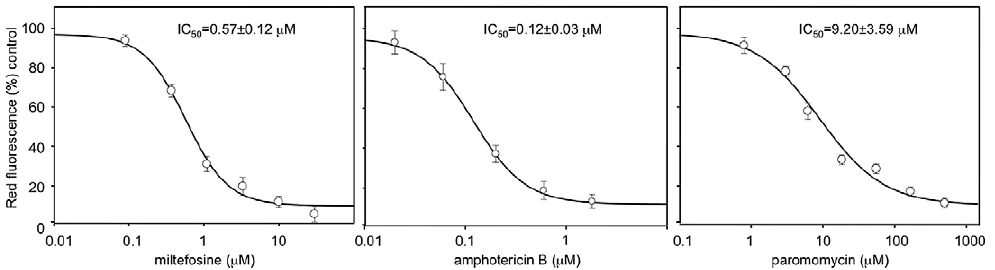
Figure 4. IC 50 calculation after a 72-h period of exposure to currently used leishmanicidal drugs in infected peritoneal mouse macrophages with mCherry + L.major . Drugs were added in a threefold dilution series, being the highest concentration 100, 2 and 500 m M for miltefosine, amphotericine B and paromomycin, respectively. IC 50 values were calculated from dose-response curves performed in triplicate and repeated twice after nonlinear fitting with the SigmaPlot